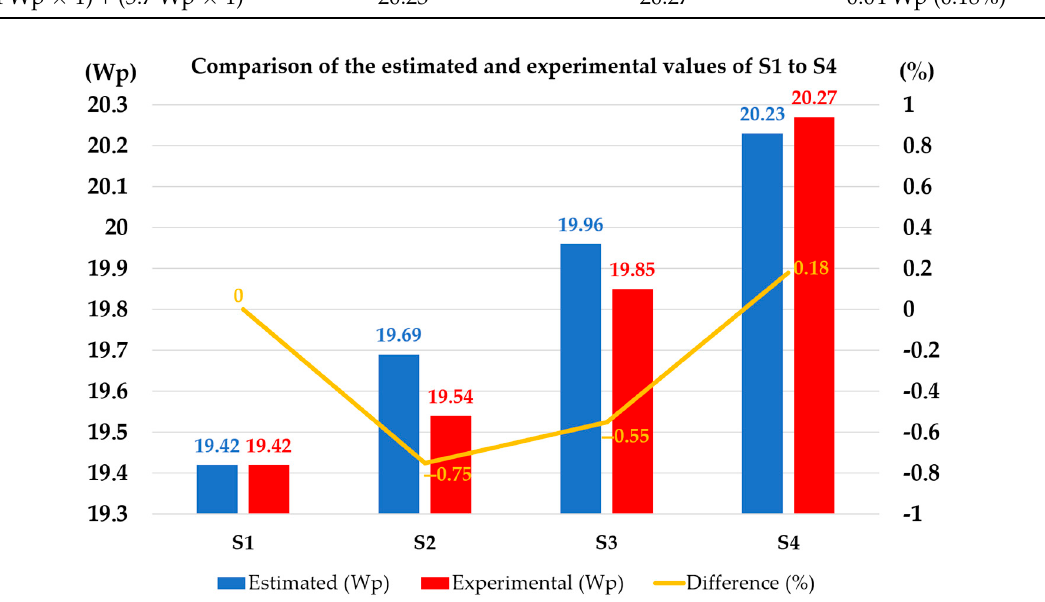
Figure 8. Comparison chart of estimated and experimental values of the samples S1–S4. Table 7. Comparison of S1–S4 samples before and after the damp heat 1000 h test.